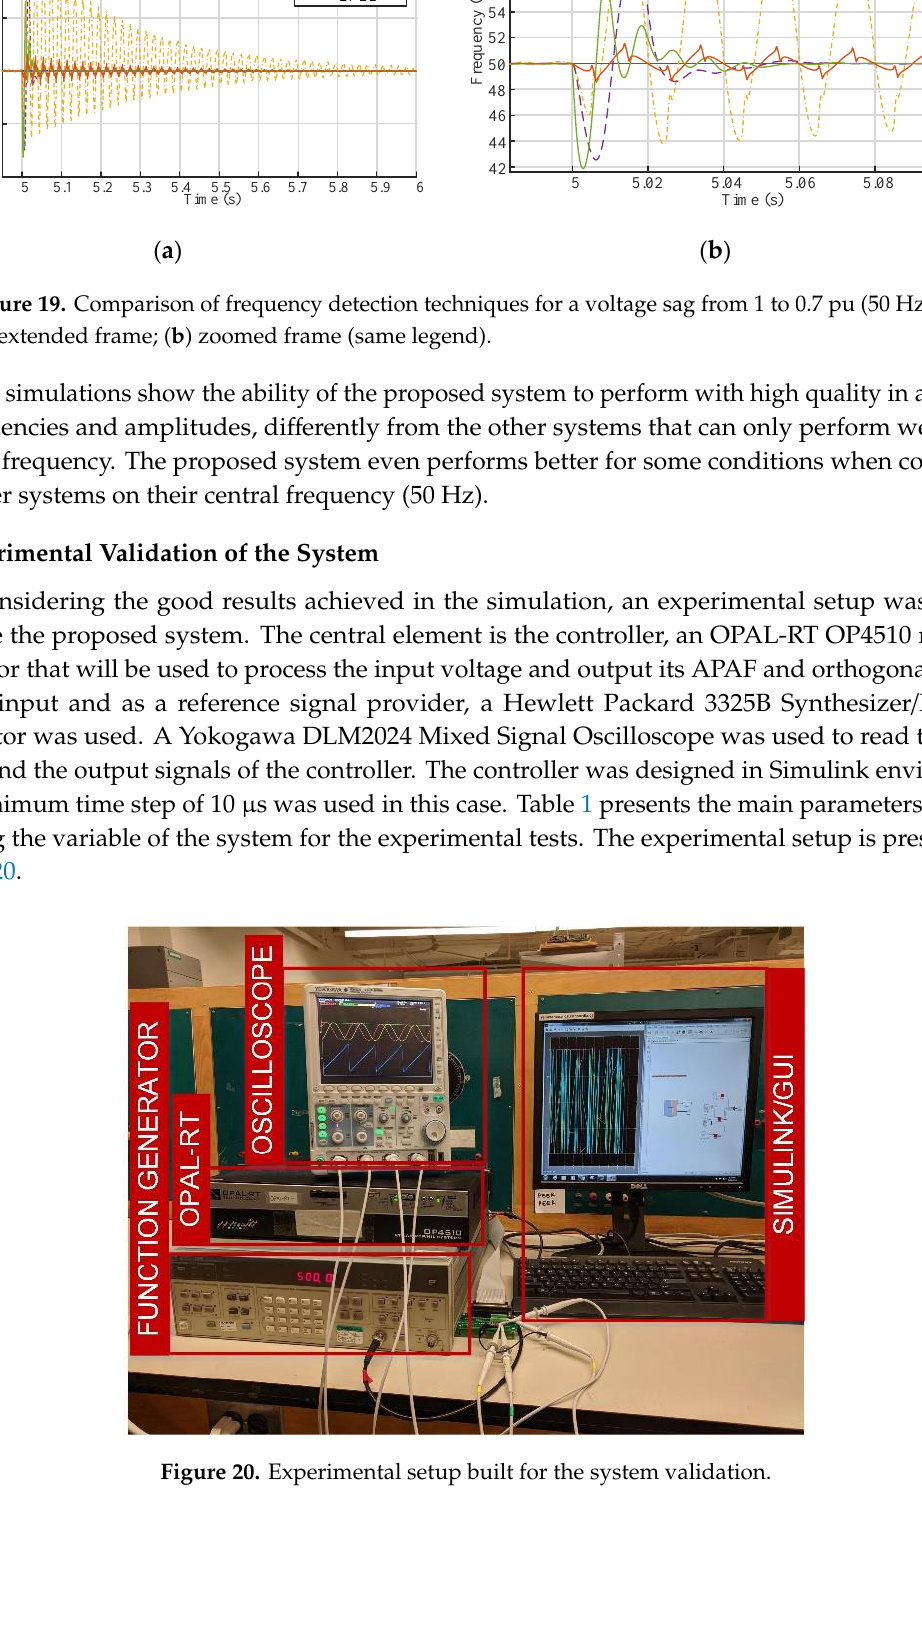
for ( a ) extended frame; ( b ) zoomed frame.